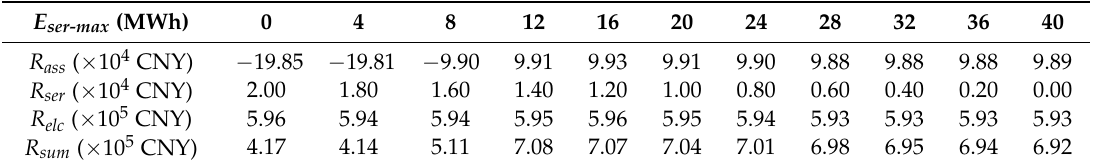
Table 5. The revenue of VPP of typical scenario 12.